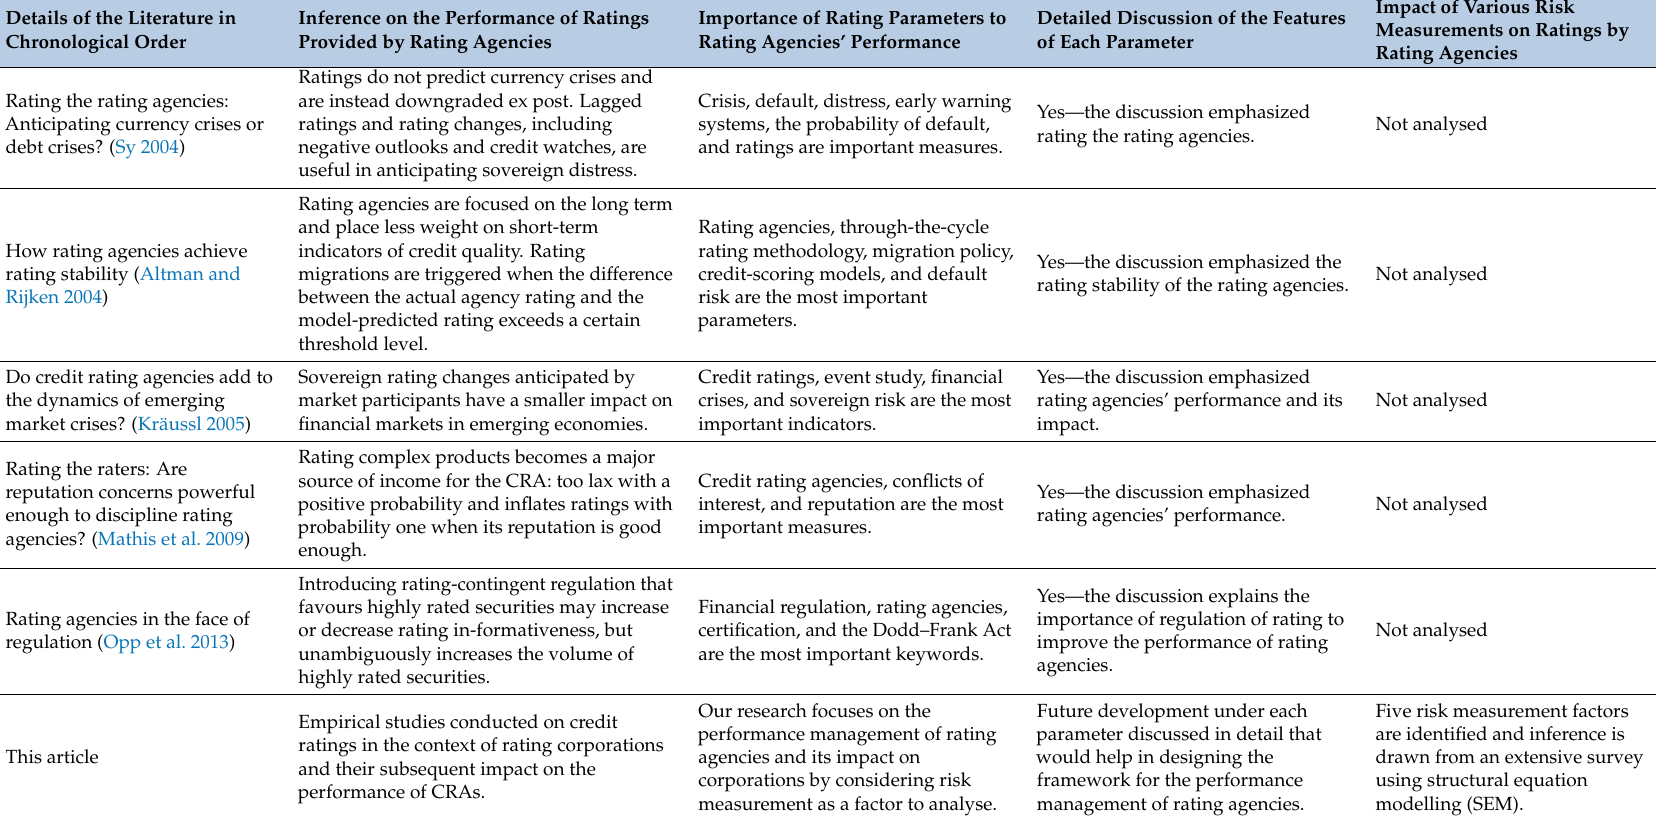
Table 1. Comparison of Empirical Studies on the Performance Management of Credit Rating